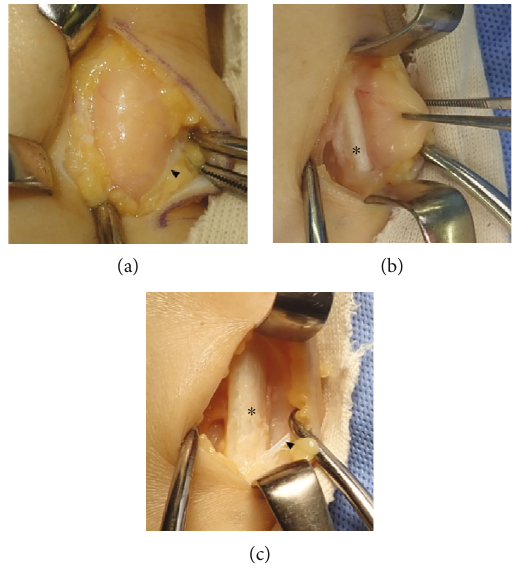
Figure 3: Intraoperative photograph of the lesion. The tumor is located under the crural fascia (arrowhead). The paratenon was partially continuous with the surrounding capsule of the lipoma. There was no adhesion adjoining the lesion to surrounding tissues. No signi fi cant damage or degeneration of the Achilles tendon (asterisk) was con fi rmed.